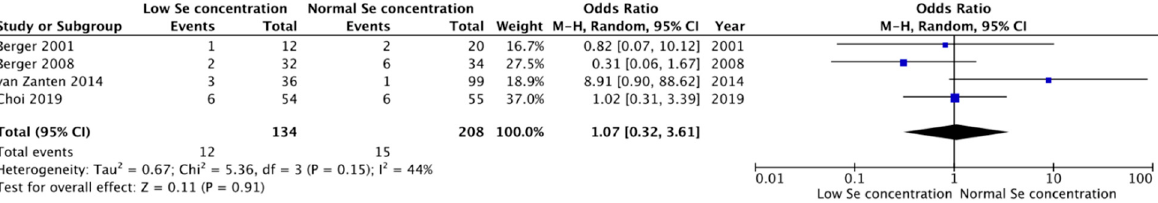
Figure 3. Forest plot of the impact of low serum Se concentration on the presence of infection of in patients with severe trauma.